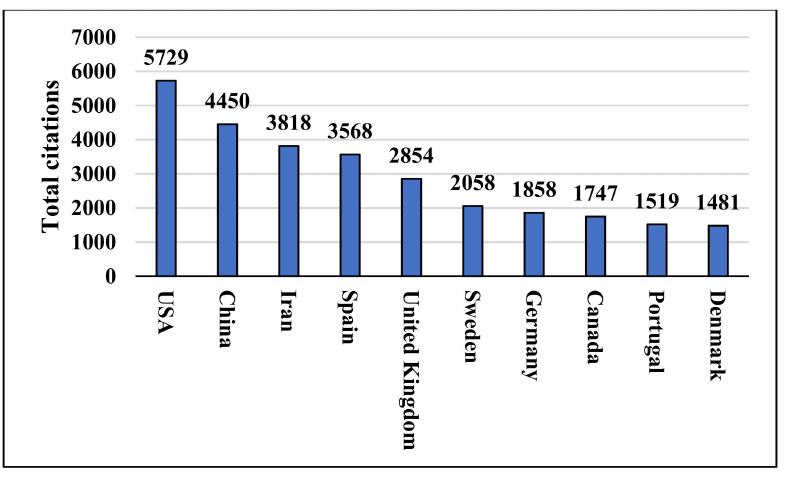
Figure 6. Total citations per country. Source: own study using data from Bibliometrix.